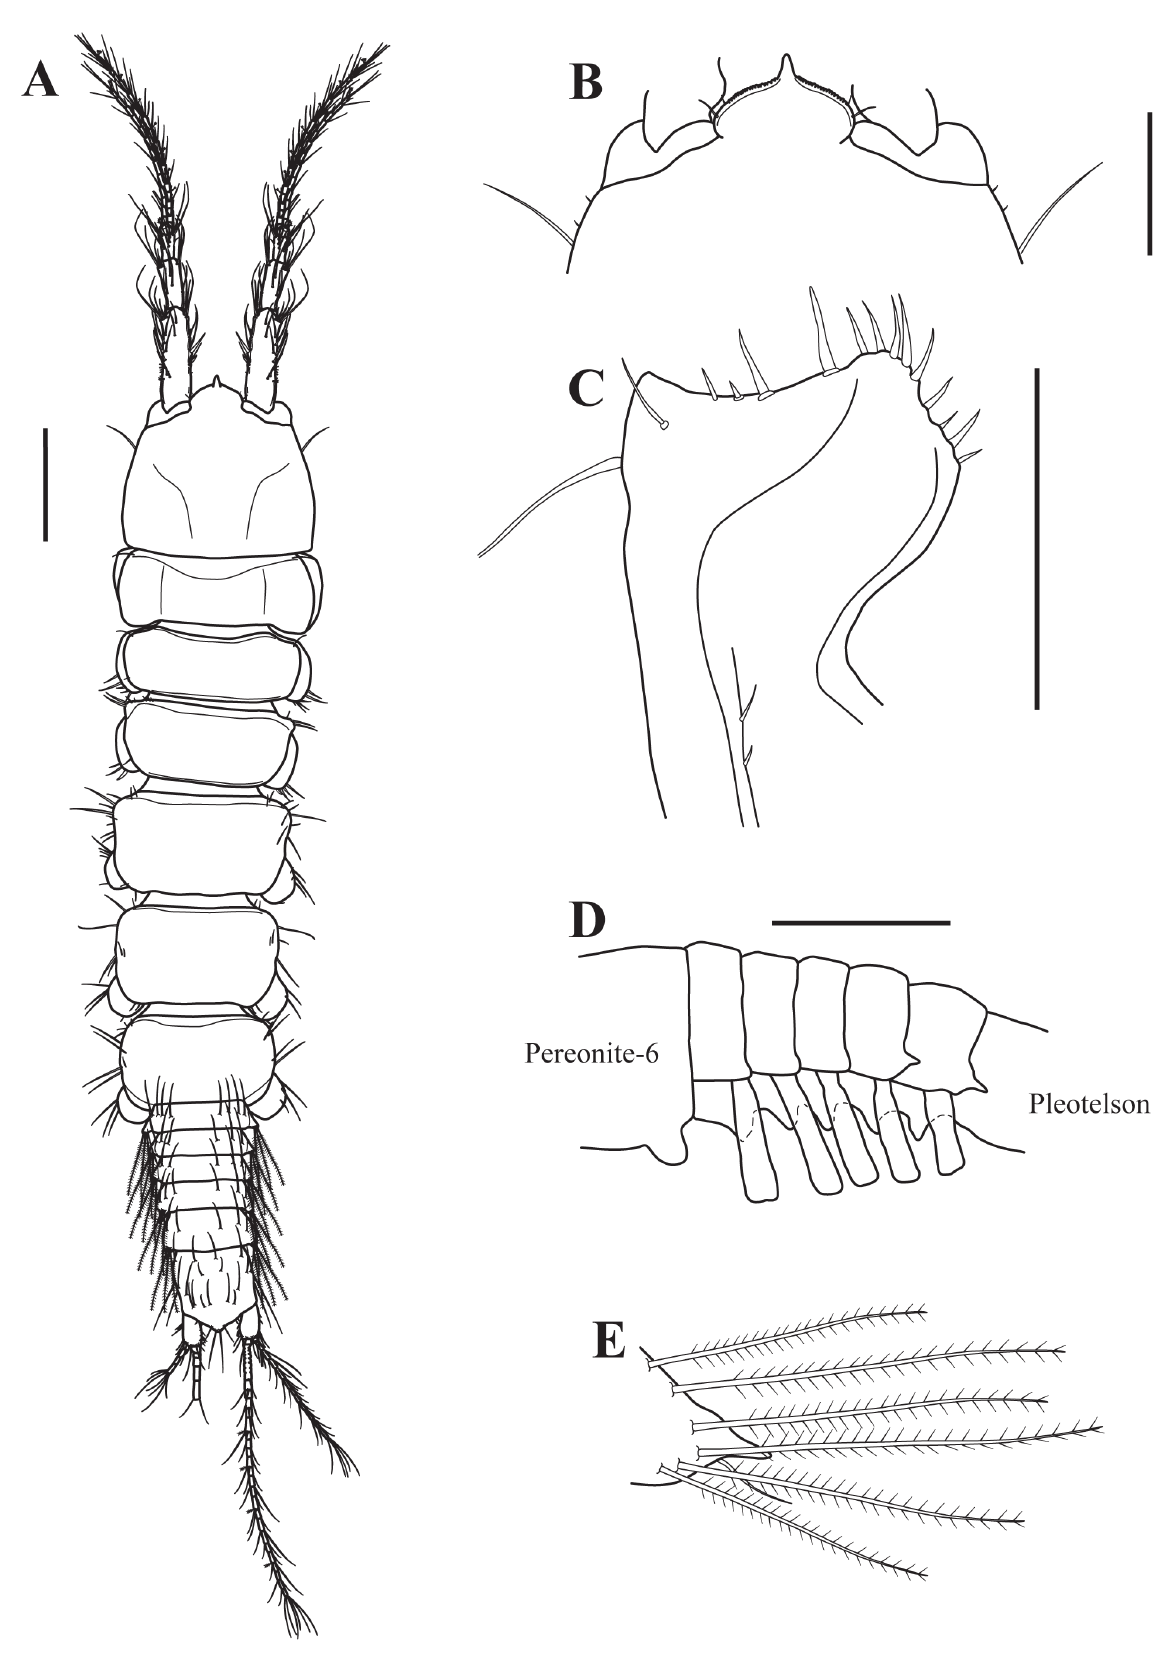
Figure 2. Brachylicoa lui sp. n. holotype female with oostegites and genital cone. A dorsal view; B enlargement of rostrum; C an- teroventral fold of carapace; D lateral view of pleonites; E enlargement of lateral view of pleonite-5 tip. Scale bars = 1.0 mm for A and 0.5 for B − C